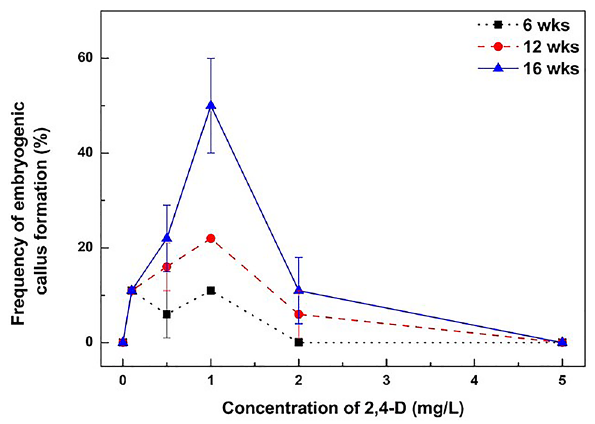
Figure 1. Effects of 2,4-D concentrations on embryogenic callus formation from immature zygotic embryos. Each symbol